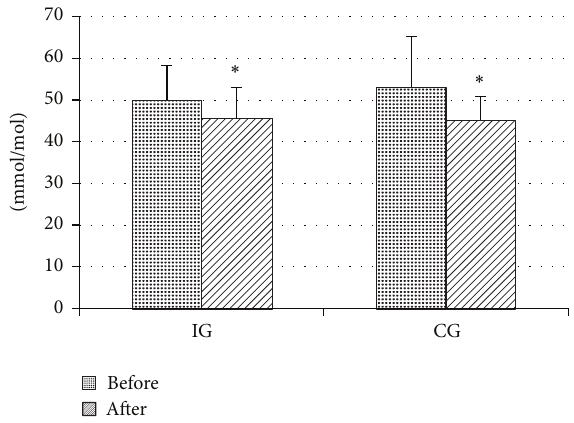
Figure 1: Glycated hemoglobin (HbA1c) before and after 3-month intervention period in control (CG) and intervention groups